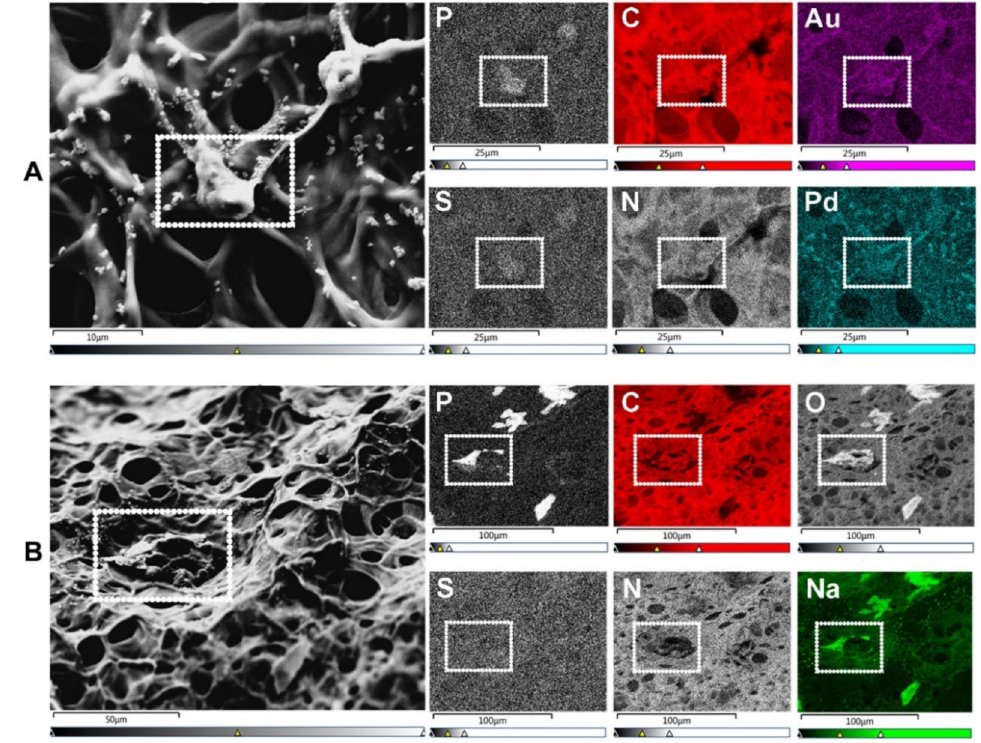
Figure 3. SEM-energy dispersive X-ray spectroscopy (EDX) elemental mapping. Images show human umbilical vein endothelial cells (HUVECs) on the surface of a gelatin methacryloyl (GelMA) hydrogel. ( A ) SEM allows for the visualization of cells (surrounded by a white dotted rectangle), while EDX identifies the elements present in both cells and hydrogels. These elements include non-metals such as phosphorus (P—a marker of DNA/nuclei), carbon (C), sulfur (S), and nitrogen (N). Transition metals used for coatings, such as gold (Au) and palladium (Pd), are also identified with EDX. Scale bars represent 10 µ m and 25 µ m. ( B ) In specimens with marked heterogeneity, EDX facilitates the identification of cells on the hydrogel surface (white dotted rectangle) that otherwise would not be distinguishable due to the condensation of the polymer network. Additional elements relevant to cell biology include non-metals, e.g., oxygen (O), and alkali metals, e.g., sodium (Na). Scale bars